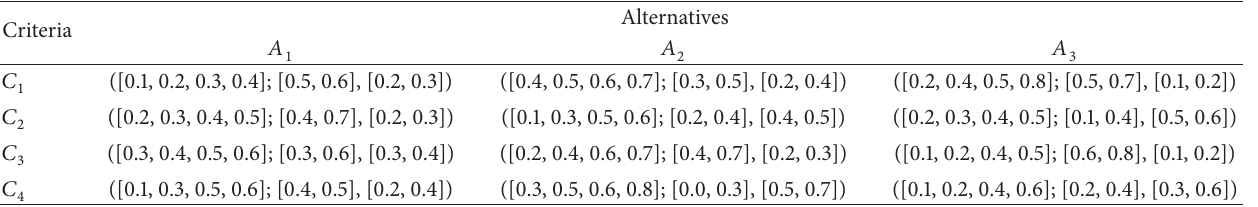
Table 7: Decision matrix 𝐷